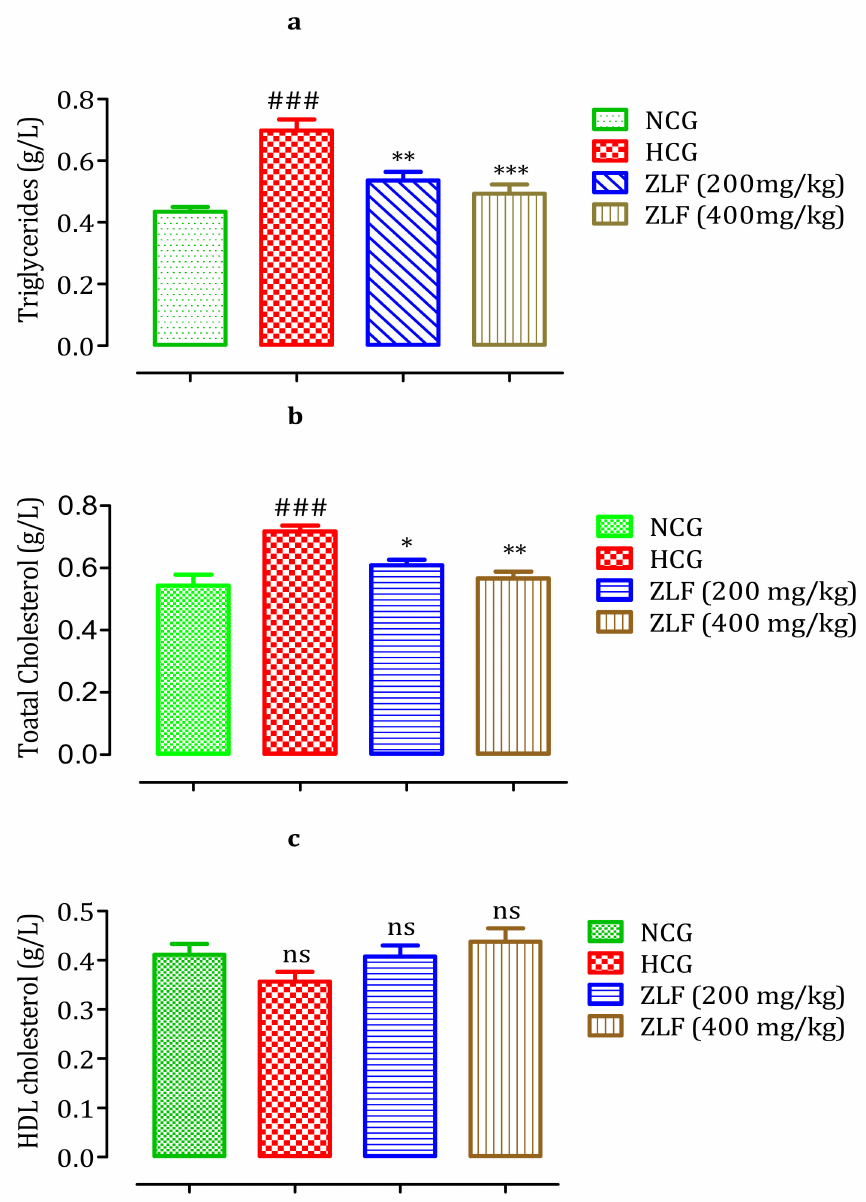
Figure 4. Effect of the aqueous ZLF extract on serum Triglycerides ( a ), Total cholesterol ( b ), and HDL-cholesterol ( c ) in mice exposed to HFD. Data are mean ± SEM, n = 6. ### p ≤ 0.001 versus NCG. * p < 0.05, ** p < 0.01, *** p < 0.001 versus HFD group. ns: not